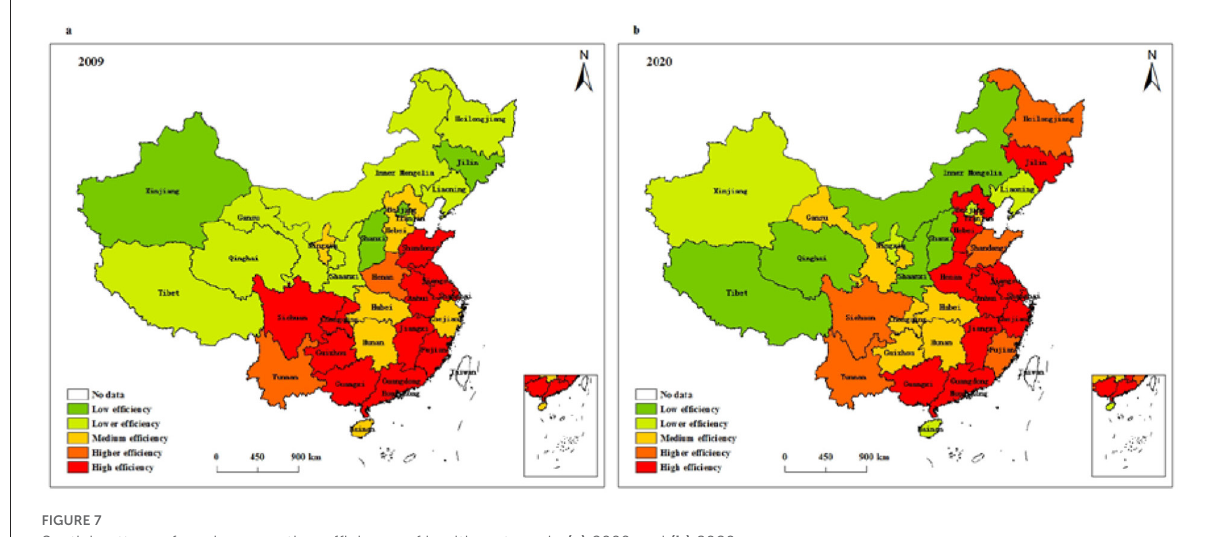
FIGURE7 Spatial pattern of service operation efficiency of health systems in (a) 2009 and (b) 2020.